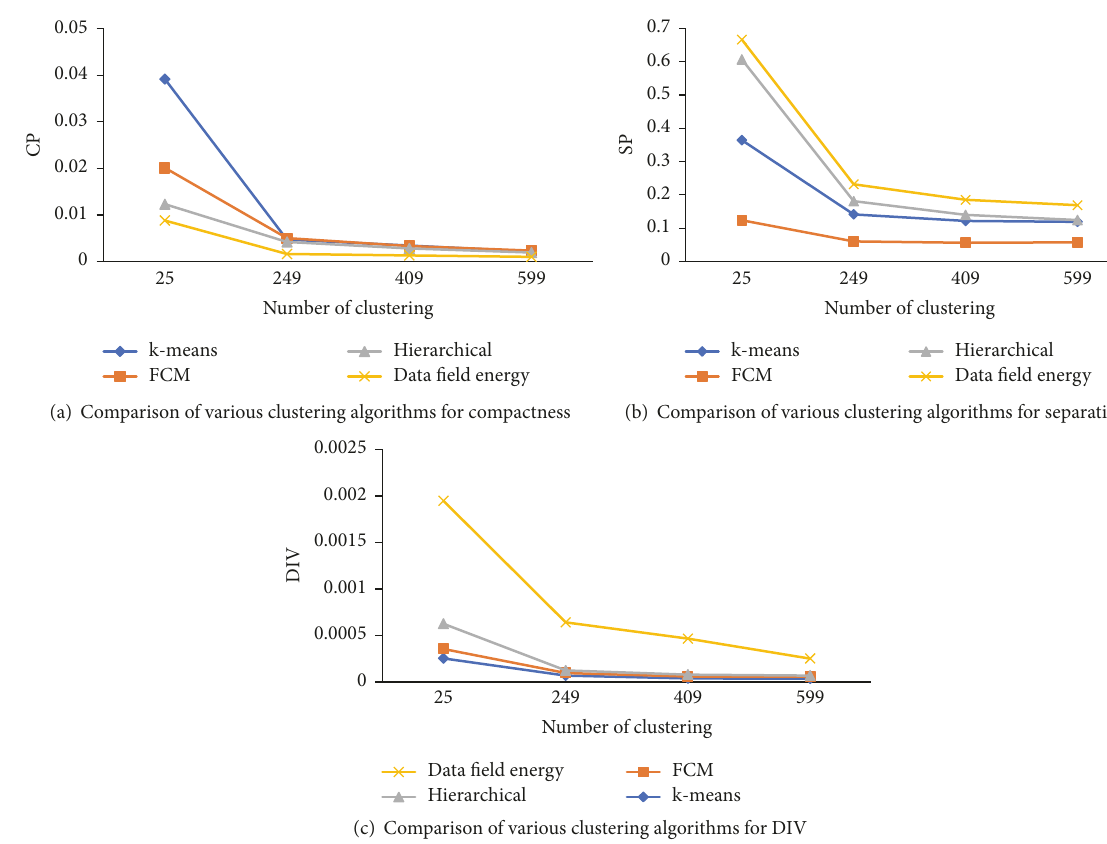
Figure 7: Comparison of various clustering algorithm evaluation